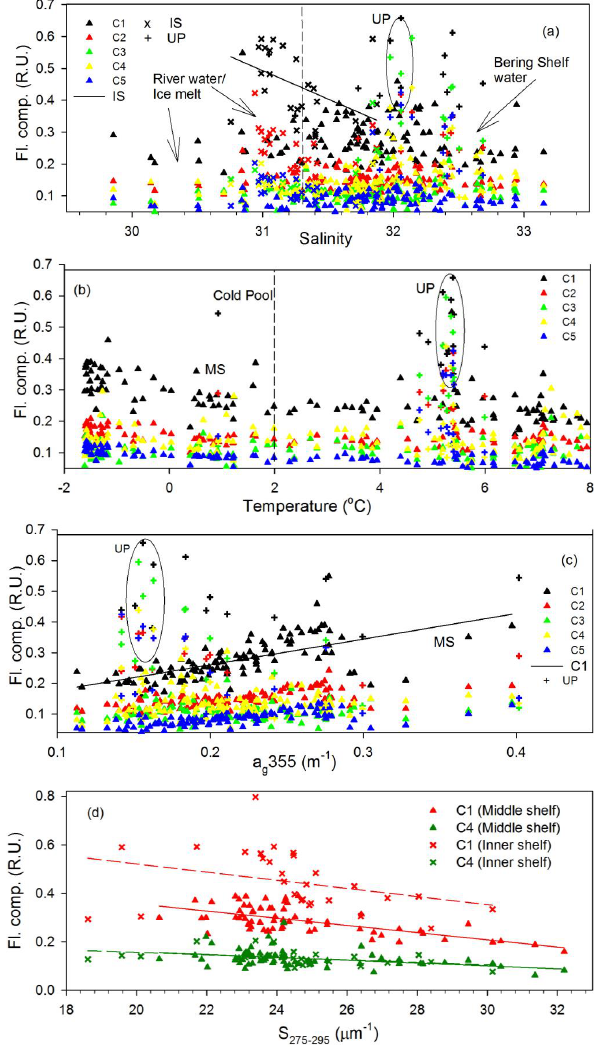
Figure 8. Relationships between (a) salinity (b) temperature, (c) a g 355, and (d) S 275 − 295 and the fluorescence components C1, C2, C3, C4, and C5. Triangles are for data from the middle and outer shelf/slope, x for the inner shelf (IS), and + for the Unimak Pass (UP)